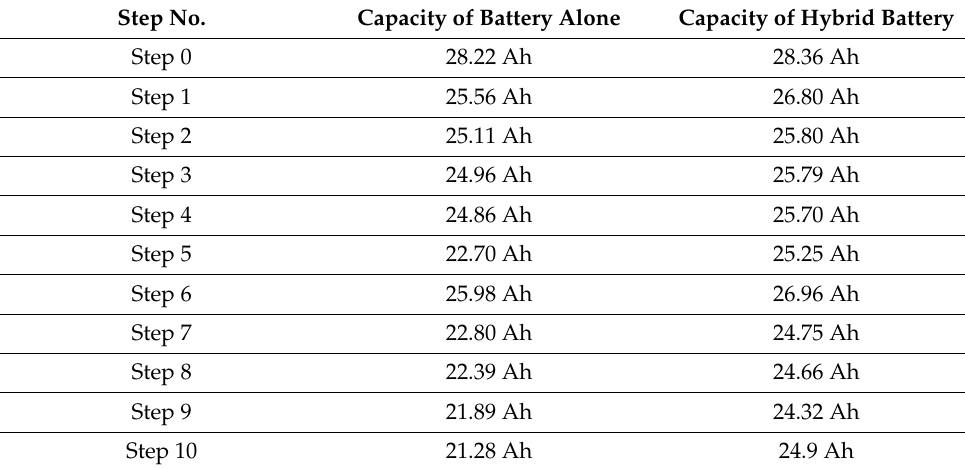
Table 3. Capacity measurement